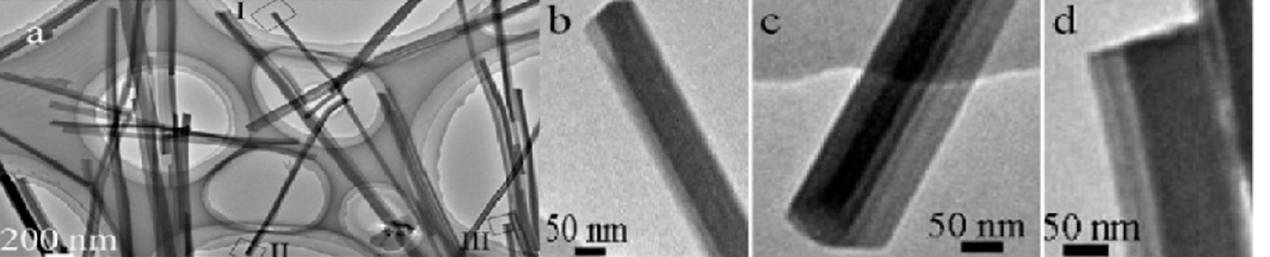
Figure 5. ( a ) The typical TEM images of the NiC 2 O 4 ·2H 2 O precursors prepared at 220 °C for 12 h. ( b – d ) TEM images at high magnification from rectangles I–III in [65].